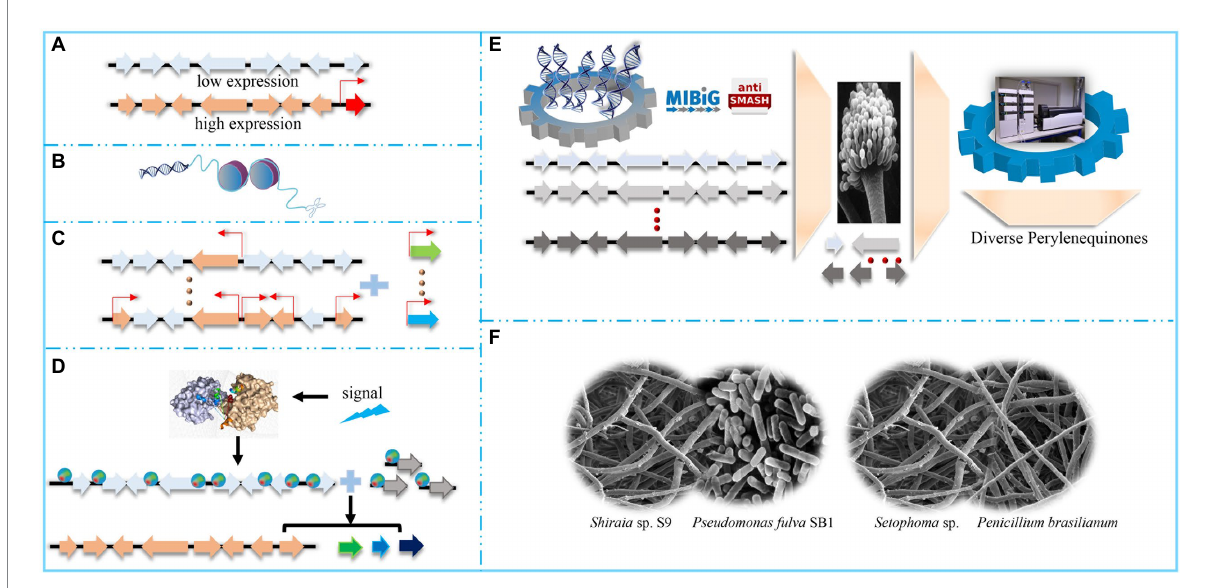
FIGURE 3 Diverse strategies to activate or broaden perylenequinone pools. (A) Activate the perylenequinone pathway by overexpressing pathway-specificity transcriptional factors. (B) Activate the perylenequinone pathway by engineering epigenetic regulators. (C) Enhance the perylenequinone pathway by increasing the central pathway. (D) Enhance the perylenequinone pathway by signal pathways. Environmental, chemical and physical signals trigger relevant global regulators, which regulate perylenequinone-linked genes by activating these genes. (E) Construct a diverse perylenequinone platform in tractable Aspergillus species. (F) Improve the perylenequinone pathway by microorganism co-culture, including bacteria-fungi co-cultures and fungi-fungi